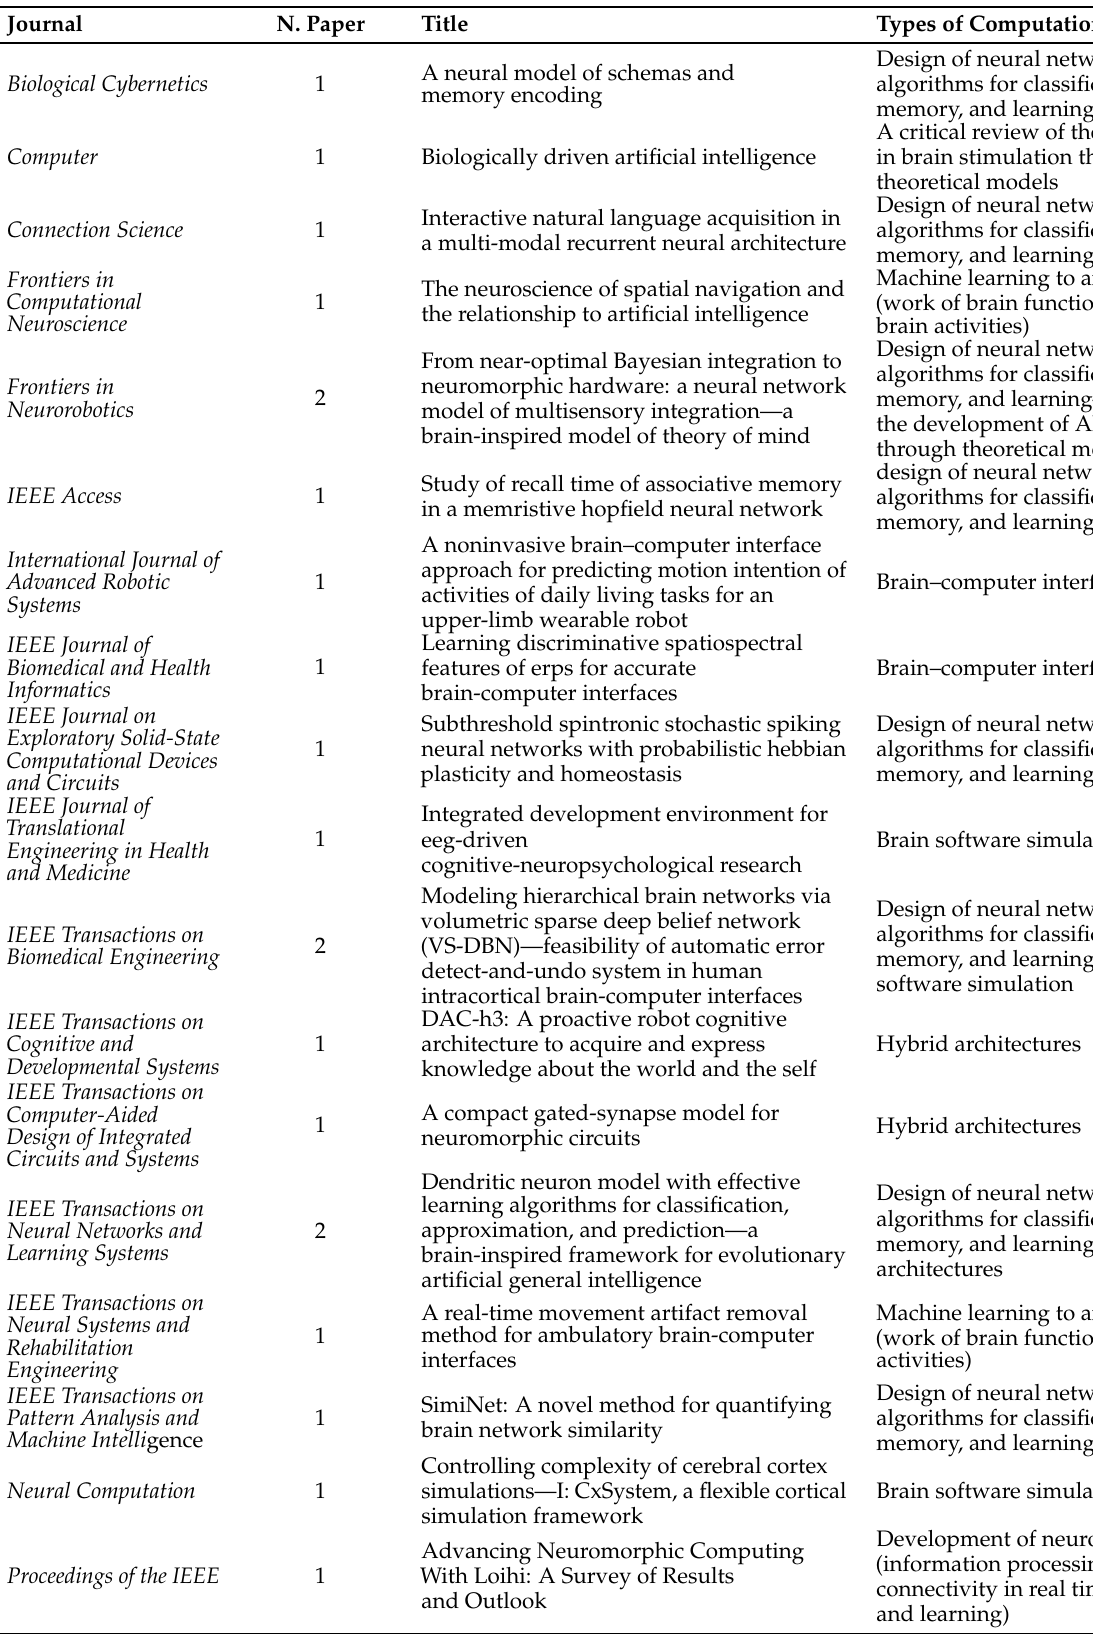
Table 3. Total of publications classified by type of